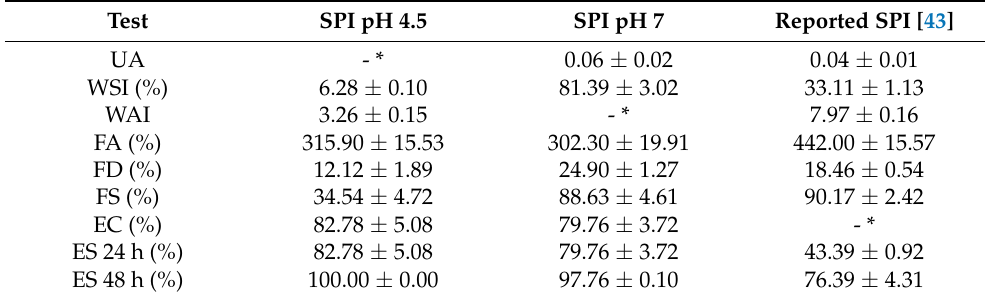
Table 8. Functional properties and urease activity of